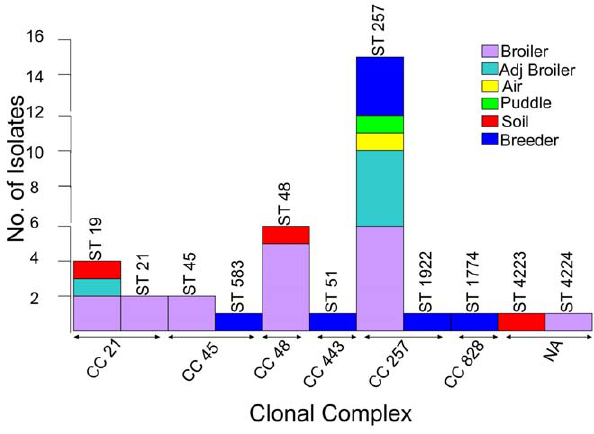
Figure 6. Distribution of CCs and STs according to source.